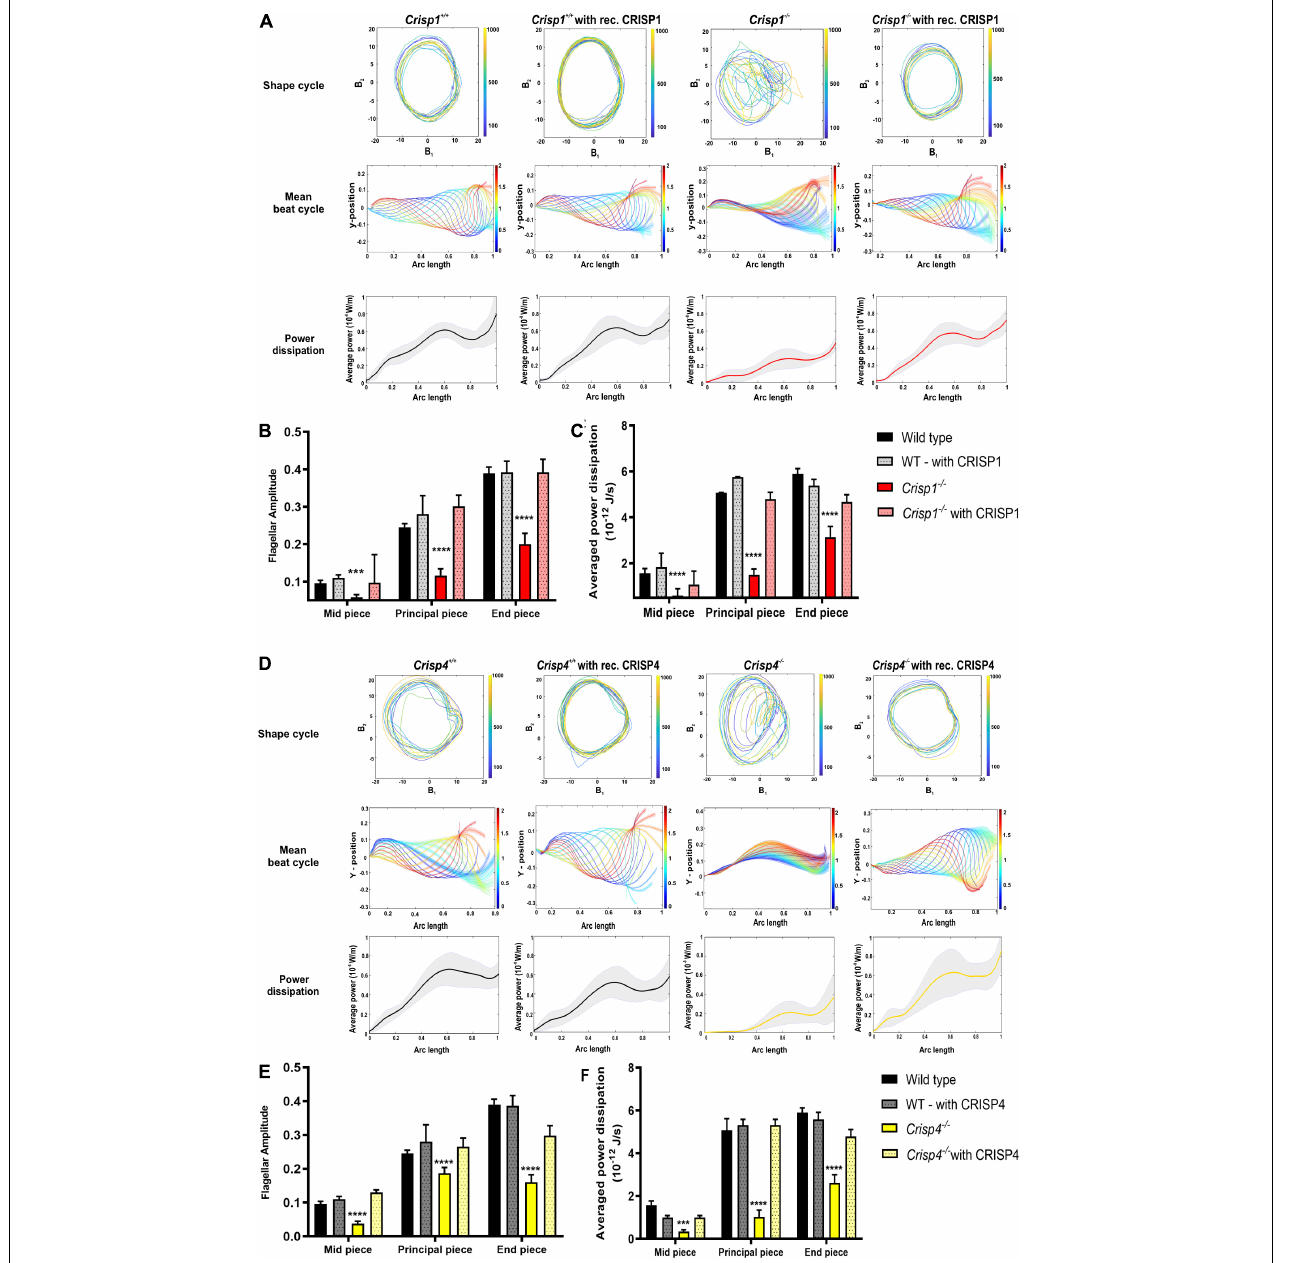
FIGURE 6 | Effects of recombinant epididymal CRISPs on sperm from Crisp1 and Crisp4 wild type and knock out mice. (A) The representative shape cycles of sperm flagellar beating, reconstruction of mean beat cycle and analysis of power dissipation (10 − 8 W/m) along the flagella of the sperm from Crisp1 wild type (black) and knock out (red) mice before (solid bar) and after (dotted bar) exposure to recombinant CRISP1 protein. N = 10–15 sperm/genotype were analyzed, and representative mean beat cycle and shape cycles of the flagellar beating is shown. For power dissipation, the black bold line indicates averaged data across the analyzed sperm population ± SEM. (B) Analysis of flagellar amplitude along the different regions of flagella (mid-piece, principal piece, and end piece) in sperm from Crisp1 wild type and knock out mice before and after exposure to 1 µ M recombinant CRISP1 protein. See Supplementary Table 7.1 for all the possible interactions between exposed and non-exposed genotype. (C) Analysis of power dissipation (10 − 12 J/s) along the different regions of flagella (mid-piece, principal piece, and end piece) in sperm from Crisp1 wild type and knock out mice before and after exposure to 1 µ M recombinant CRISP1 protein. The data presented is from a total number of 10–15 sperm/genotype. *** indicates P < 0.001 as analyzed by two-way ANOVA ± SEM. **** indicates P < 0.0001 as analyzed by two-way ANOVA ± SEM. See Supplementary Table 7.2 for all the possible interactions between exposed and non-exposed genotype. (D) The representative shape cycles of the flagellar beating, reconstruction of mean beat cycle and analysis of power dissipation (10 − 8 W/m) along the flagella of the sperm from Crisp4 wild type (black) and knock out (yellow) mice before (solid bar) and after (dotted bar) exposure to 1 µ M recombinant CRISP4 protein. N = 10–15 sperm/genotype were analyzed, and representative mean beat cycle and shape cycles of the flagellar beating is shown. For power dissipation, the black bold line indicates averaged data across the